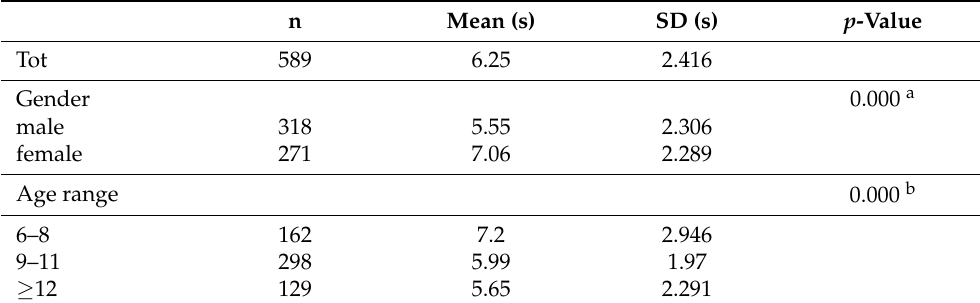
Table 1. Differences in the crunning test performances by gender and age